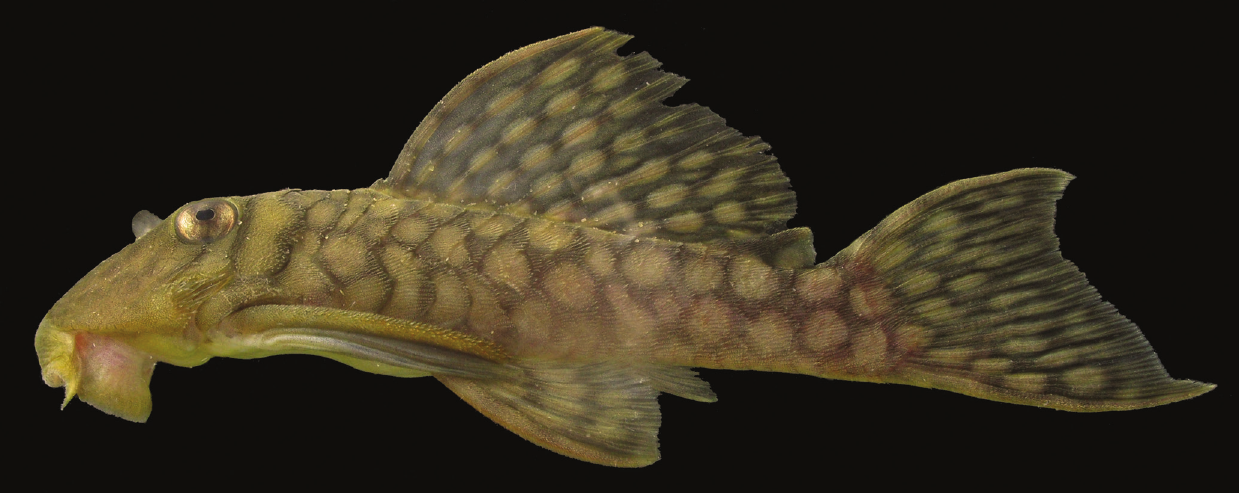
Fig. 15. Color in live of Spectracanthicus zuanoni . Image by J.